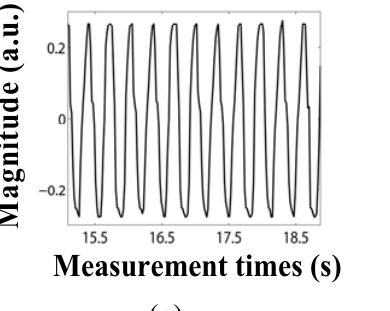
Figure 12. ( a ) Dynamic load experiment results under vibration frequency of 3 Hz; ( b ) Signal frequency analysis under vibration frequency of 3